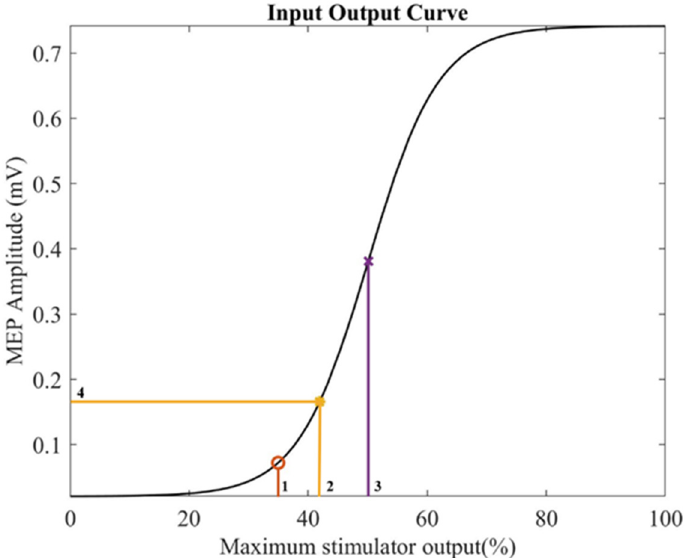
Figure 1. Input–output curve of one participant from this study. The labels describe the following parameters: (1) Resting motor threshold (RMT), (2) 120% RMT, (3) Intensity at half-maximum amplitude (S50) (4) MEP amplitude at 120% RMT (MEP amp ). The offset and MEP max is visible in the IOC as maximum and minimum MEP values, respectively. Peak Slope (PS) is the maximum slope of the curve which can be obtained at S50.